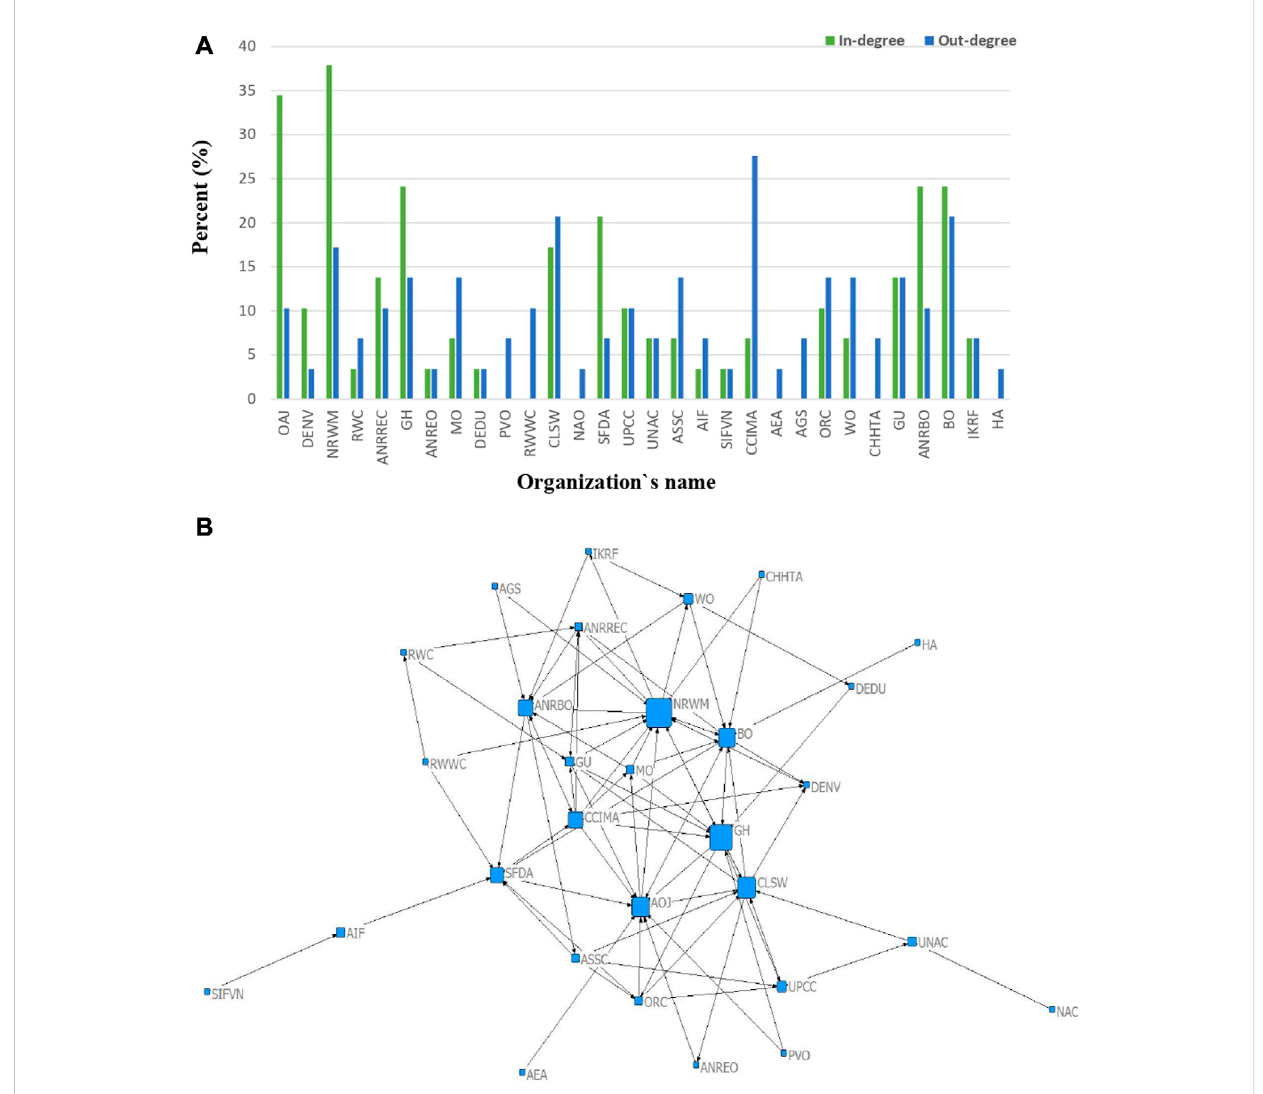
FIGURE 4 SNA results of the participation network. (A) In-degree and out-degree centrality. (B) Between centrality ( Larger size indicates higher between centrality